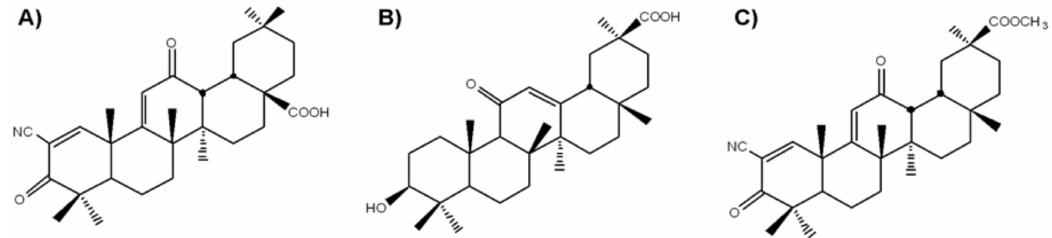
Figure 1. Chemical structure of CDDO (2-cyano-3,12-dioxooleana-1,9-dien-28-oic acid) ( A ); 18 β H-GA (18 β H-glycyrrhetinic acid) ( B ); soloxolone methyl (methyl-2-cyano-3,12-dioxo-18 β H-olean-9(11),1(2)- dien-30- oate; SM) ( C